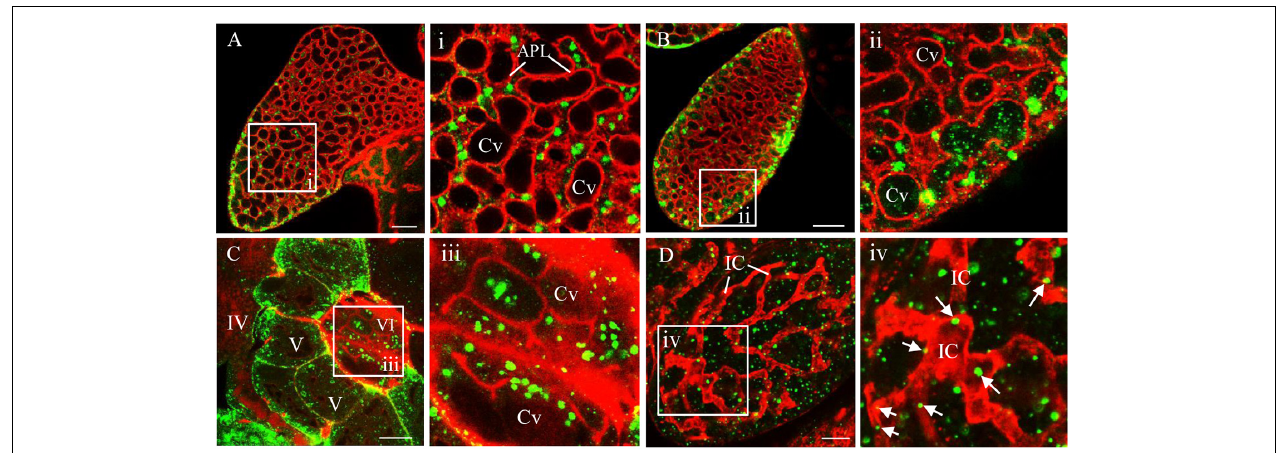
FIGURE 2 | Immunofluorescence microscopy showing the release of RDV from salivary gland cells. (A) Abundant RDV virions that have accumulated inside the cytoplasm at the periphery of apical plasmalemma of type III-cells of salivary gland. (B–D) A number of RDV virions entering the cavities of type III (B) or VI (C) cells or into the canaliculi of type IV-cells of salivary gland (D) . The salivary glands of leafhoppers at 12 days padp were stained with virus-FITC (green) or actin dye phalloidin-rhodamine (red), and then examined by confocal microscopy. Arrows indicate virus in the canaliculi. Panels i to iv are enlarged images of the boxed areas in panels (A–D) , respectively. APL, apical plasmalemma; Cv, cavity; IC, intracellular canaliculi. Bars, 20 µ m (A–C) , 10 µ m (D) .